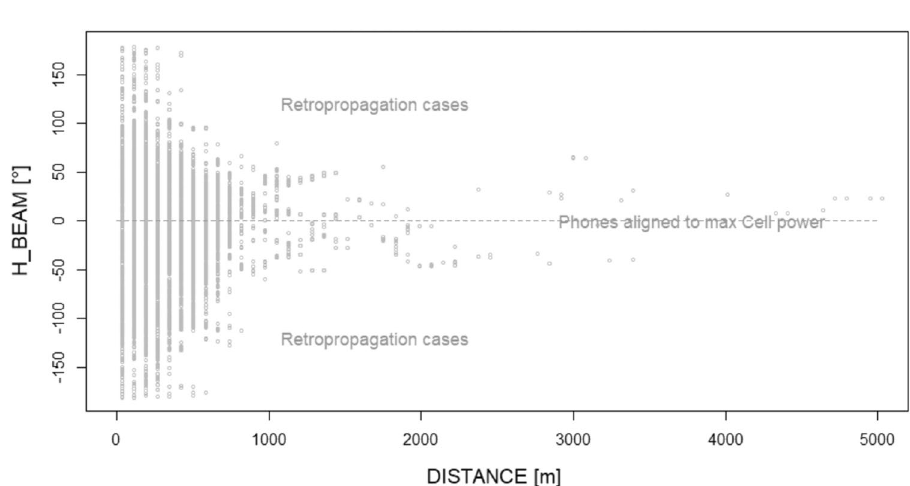
Figure 11. Angular distribution (H_BEAM) as a function of the electromagnetic distance of users from their serving BS cell, in the case of non-Sun-oriented BS cells during the two hours immediately before the 3rd July solar flare. The queues of the distribution (e.g., over + 100° and under −100°) are more populated with respect to the Sun-exposed BS cell equivalent queues (Fig.